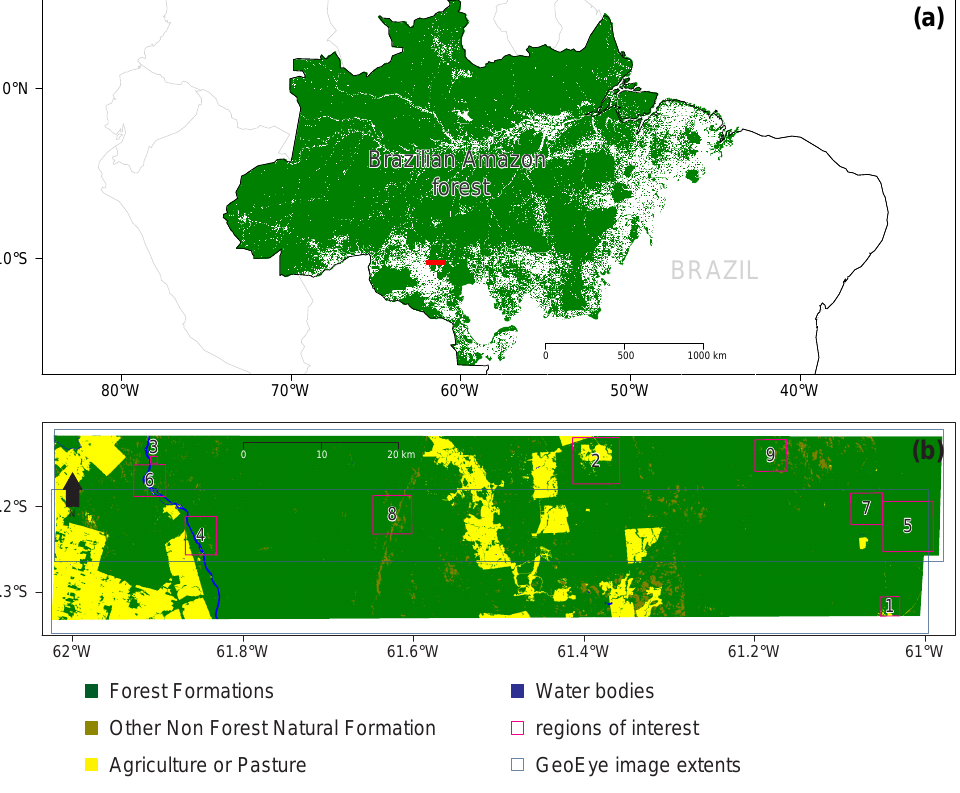
Figure 1. ( a ) Remaining Brazilian Amazon forest cover in green [8] and geographical locations of the study area in red; ( b ) region of interest with 2017 land use/cover classes from the MapBiomas project [42] and extents of the GeoEye-1 images used in this